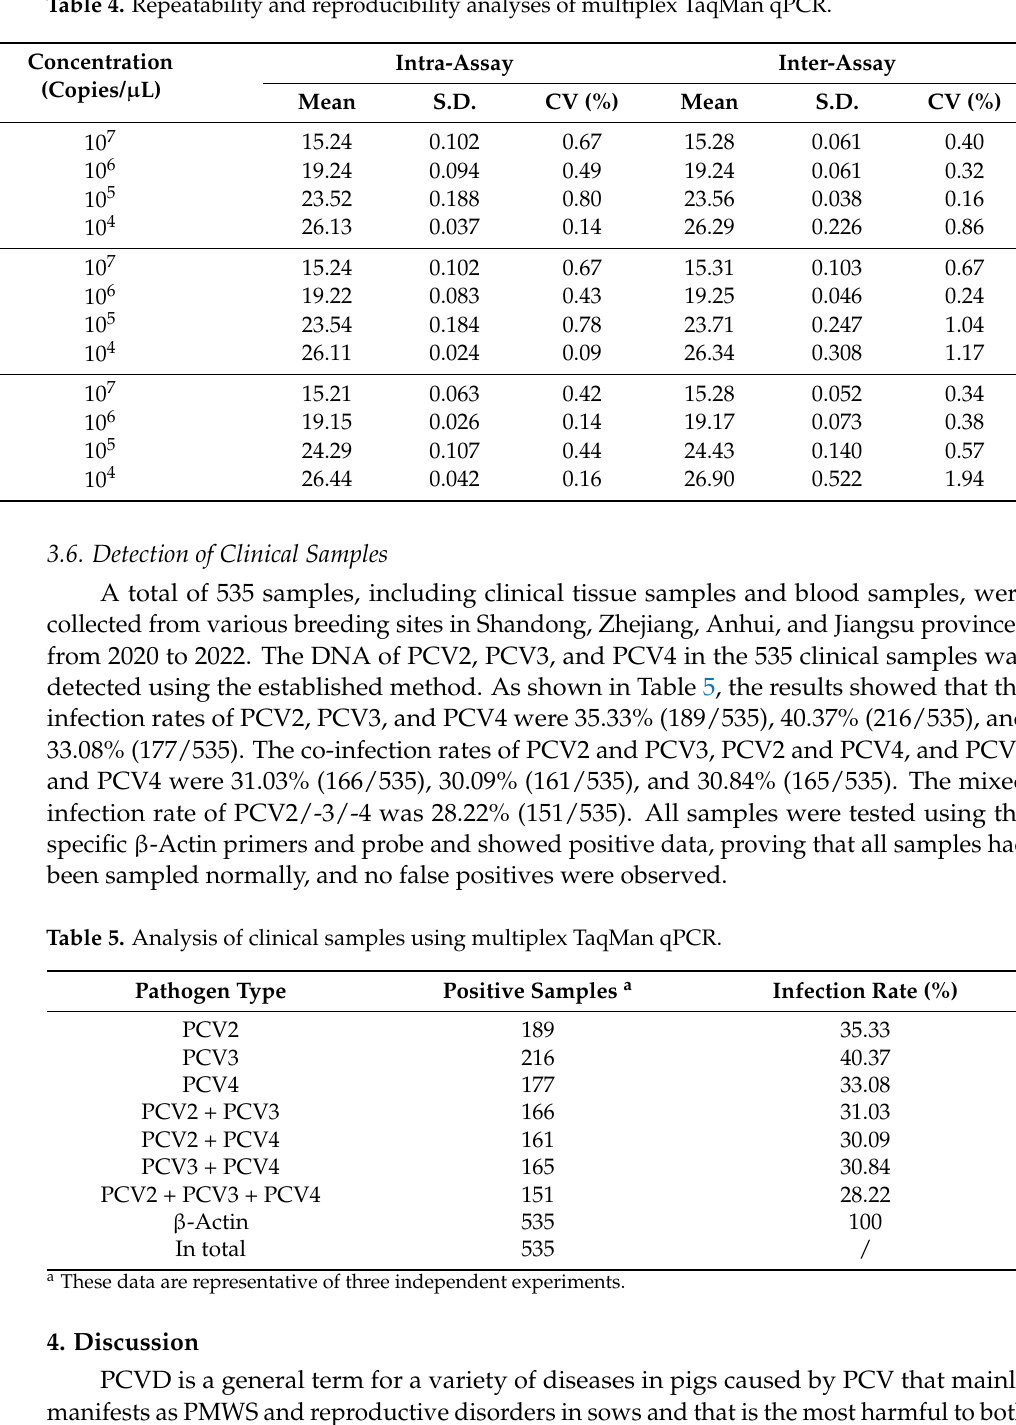
Table 4. Repeatability and reproducibility analyses of multiplex TaqMan qPCR.